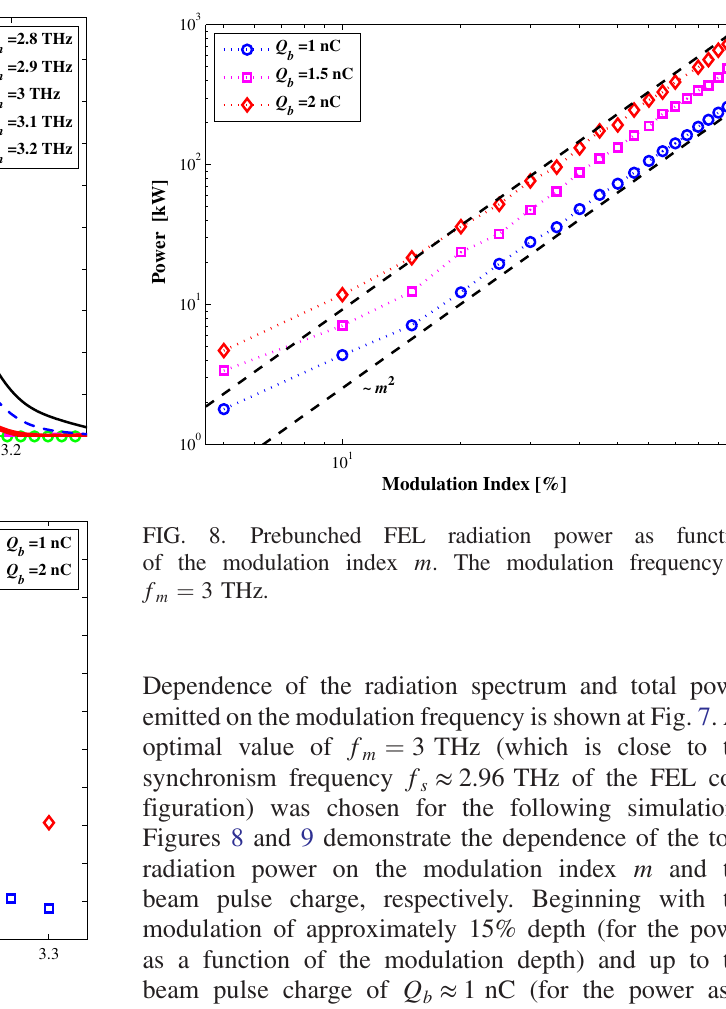
FIG. 7. Power spectrum of prebunched FEL ( Q b ¼ 2 nC, top), and the total power (bottom) in dependence on the modulation frequency f m . The modulation index is m ¼ 50% .